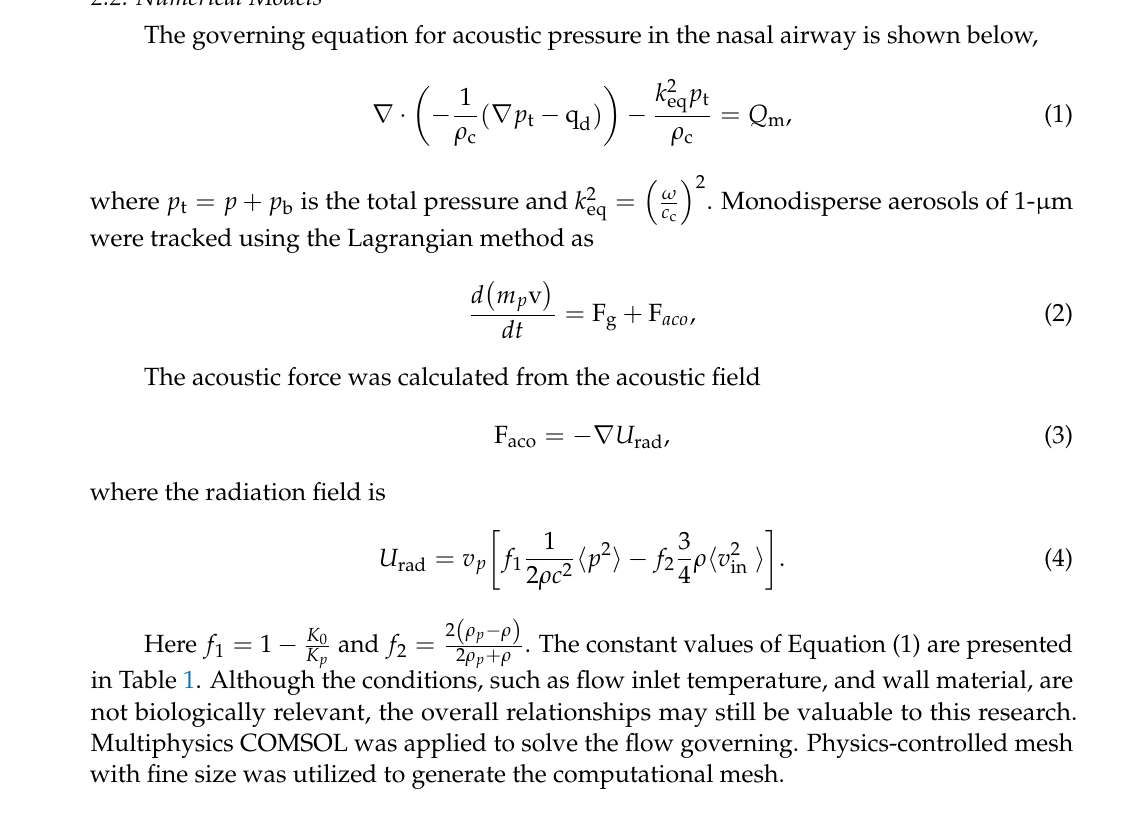
Table 1. Geometrical and physical constant values of parameters used in Equations (1)–(4). Value c c 343